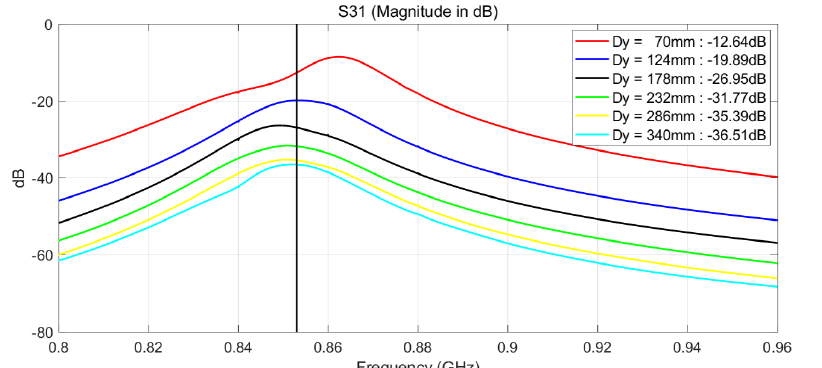
Figure 8. Simulated S31 versus distance Dy for the configuration of the antennas shown in Figure 6. Distance Dy is measured between the centres of patch